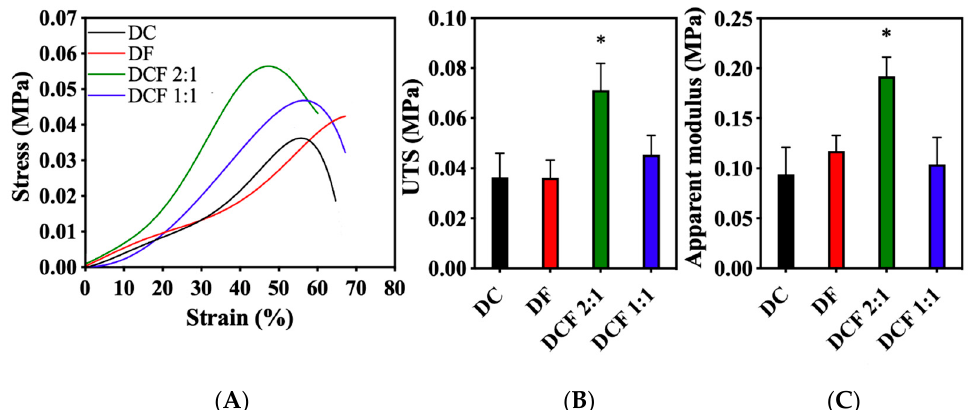
Figure 2. Mechanical properties of the as-made GAE-generated DC, DF, and DCF gels. ( A ) Repre- sentative stress–strain curves, ( B ) ultimate tensile strength, and ( C ) apparent modulus of DC, DF, DCF 2:1, and DCF 1:1 gels. The ultimate tensile strength and apparent modulus were significantly (* p < 0.05) higher in DCF 2:1 versus all other gel types.